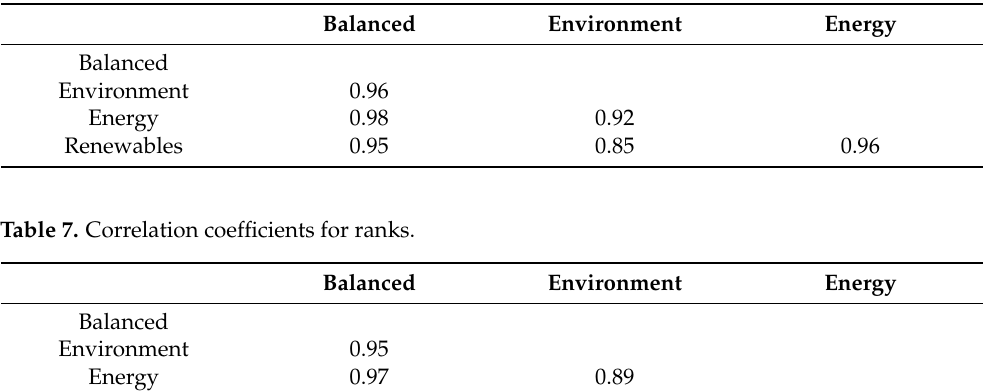
Table 6. Correlation coefficients for utility scores.